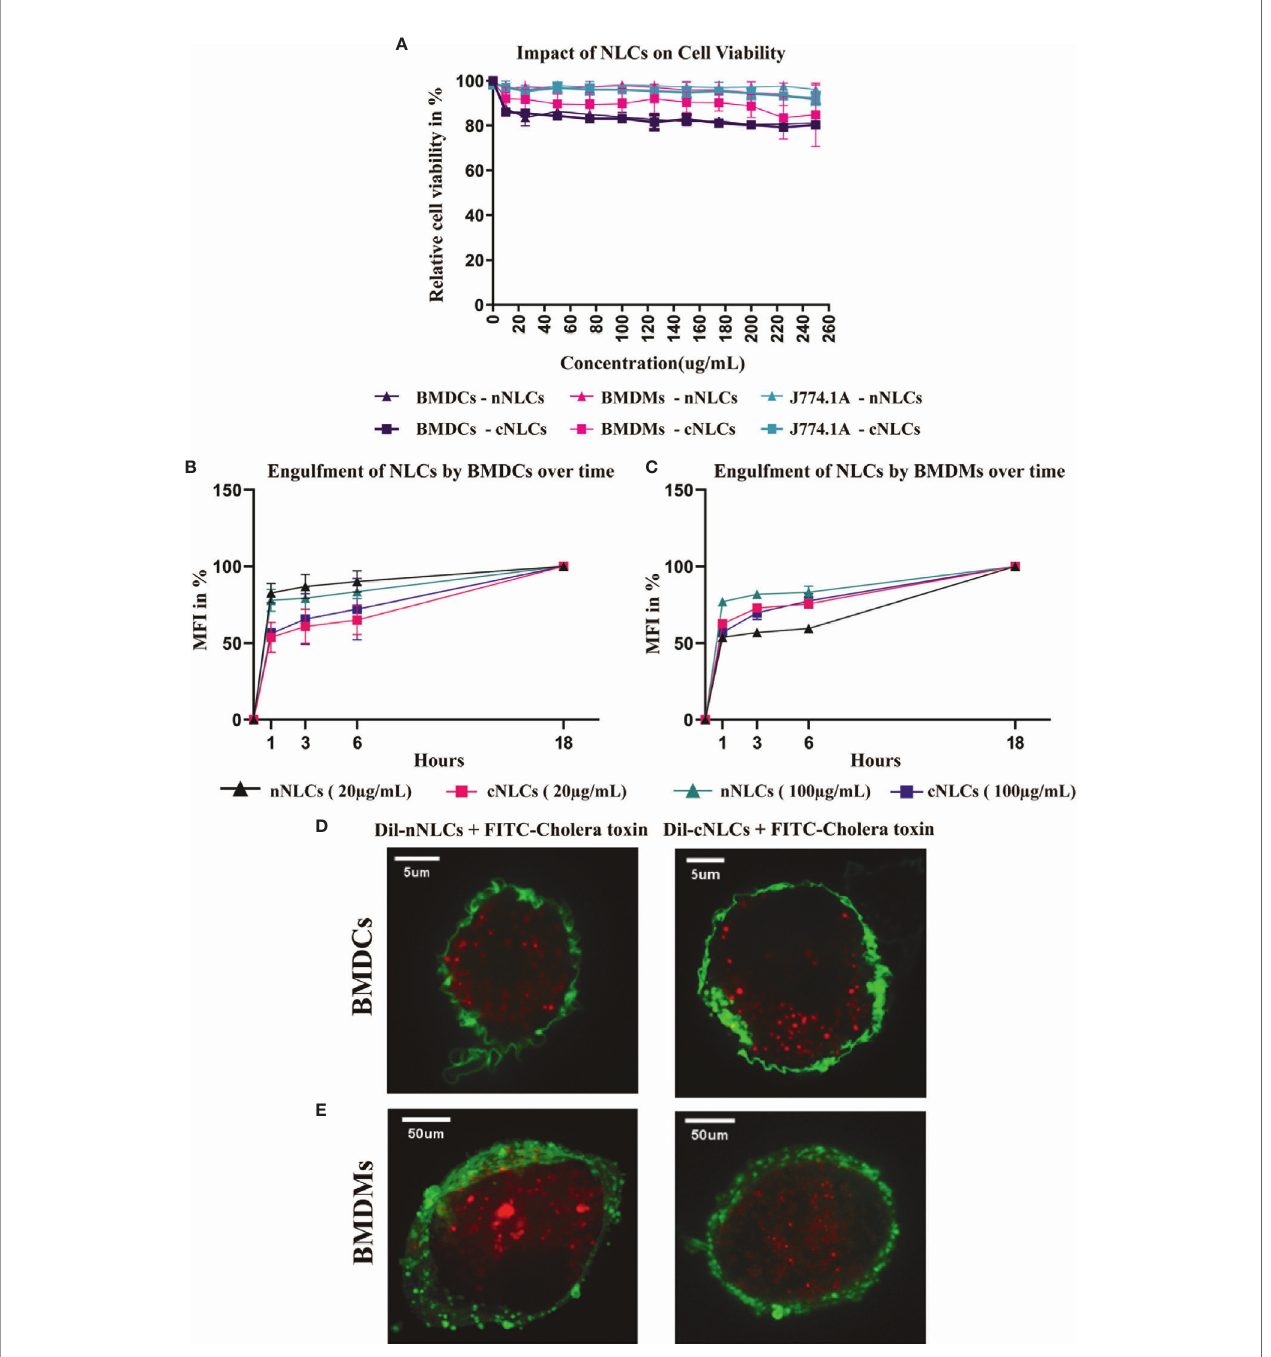
FIGURE 1 | nNLCs and cNLCs do not induce cell toxicity and are ef fi ciently internalised by APCs (A) Cell viability (LDH release assay) of BMDCs, BMDMs and J774.1A cells was analysed after exposure to different concentrations of nNLCs and cNLCs nanocarriers for 24 h. Data are displayed as mean ± SD and normalised to the untreated cells (N = 3 independent experiments). Time-dependent engulfment of both cNLCs and nNLC in BMDCs (B) and BMDMs (C) . After APCs exposure to 20 and 100 µg/ml of Dil labeled nNLCs or Dil labeled cNLCs nanocarriers for 1, 3, 6, 18 h cells were analysed by fl ow cytometry. Data are displayed as mean ± SD and presented as % of max MFI (at 18h) (N = 3 independent experiments). Confocal microscopy analysis of nNLCs and cNLCs uptake in (D) BMDCs and (E) BMDMs. After APCs exposure to 100 µg/ml of nNLCs or cNLCs nanocarriers for 24 h, cell membranes were labelled with FITC-conjugated cholera toxin (green), and nNLCs and cNLCs are observed by excitation of Dil fl uorescent dye (red). Images were acquired using a confocal spinning-disk microscope. The images displayed were representative of the majority of cells